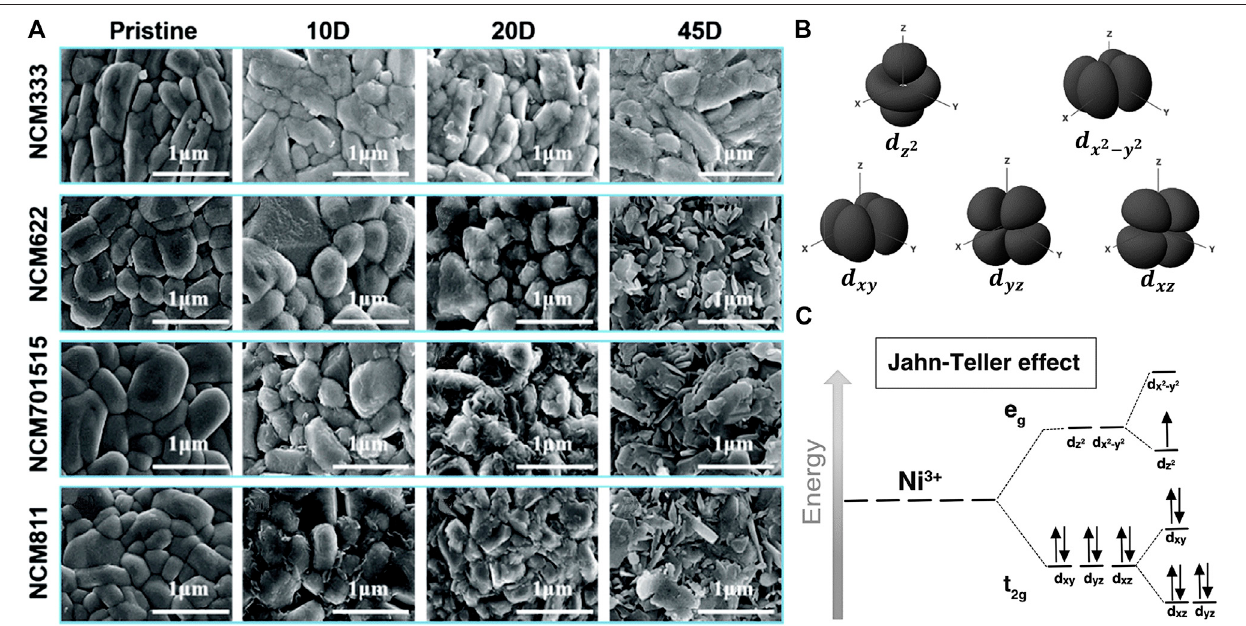
FIGURE1|(A) SEMimages ofNCM333,NCM622,NCM701515, andNCM811after0, 10,20,and 45days ofstorage (fromlefttoright, respectively)at 25 ° Cand 40% relative humidity. Adapted from [Qian et al., 2019] with permission from Royal Society of Chemistry. (B) and (C) Illustration of the Jahn- Teller effect of NiO6 with energy splitting in an octahedral complex. Adapted from [Kim et al., 2019b] with permission from Royal Society of Chemistry.